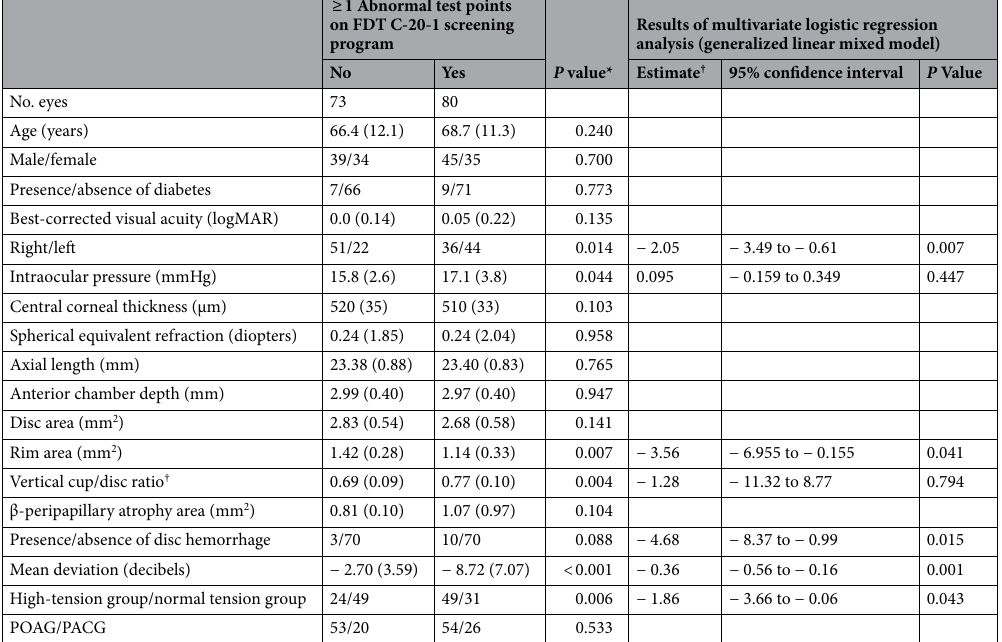
Table 3. Results of univariate and multivariate logistic regression analysis in 153 eyes with definite glaucoma of 126 patients with glaucoma for whom all parameter values used for analysis were available. The data are expressed as the mean (deviation). The high-tension group indicates eyes with primary angle-closure glaucoma and primary open-angle glaucoma with elevated pressure (> 21 mmHg); the normal-tension group are those with primary open-angle glaucoma with normal pressure (≤ 21 mmHg). logMAR logarithm of the minimum angle of resolution, FDT frequency-doubling technology, dB decibels, POAG primary open